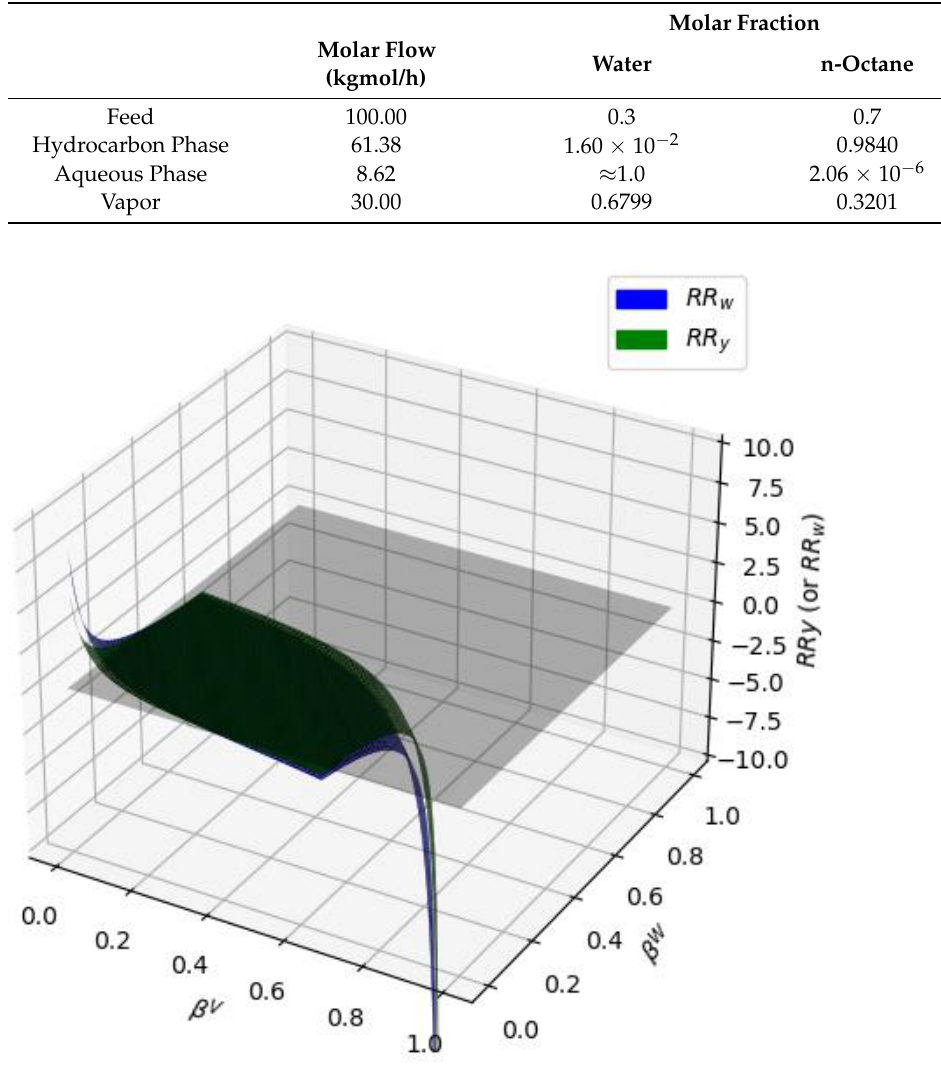
Figure 10. RR y and RR w surfaces intersecting the z = 0 plane for 30% mole water/n-octane at